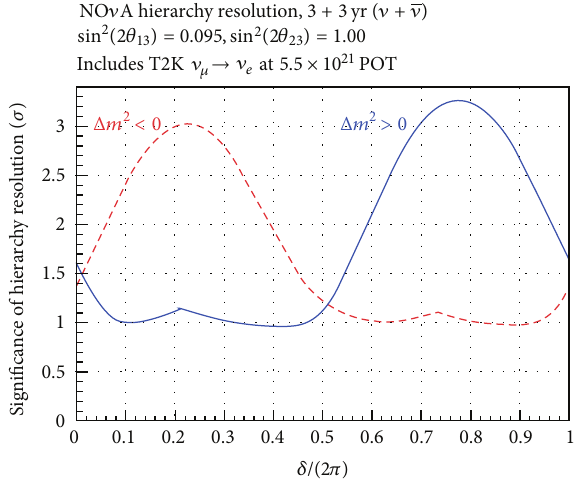
Figure 35: Same as Figure 34 except that information from the T2K experiment has been